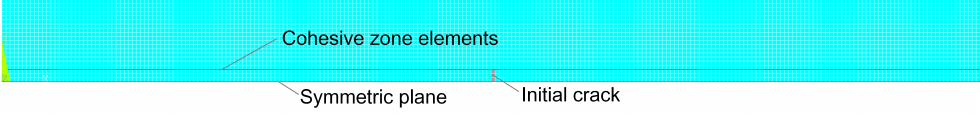
Figure 4. Finite element